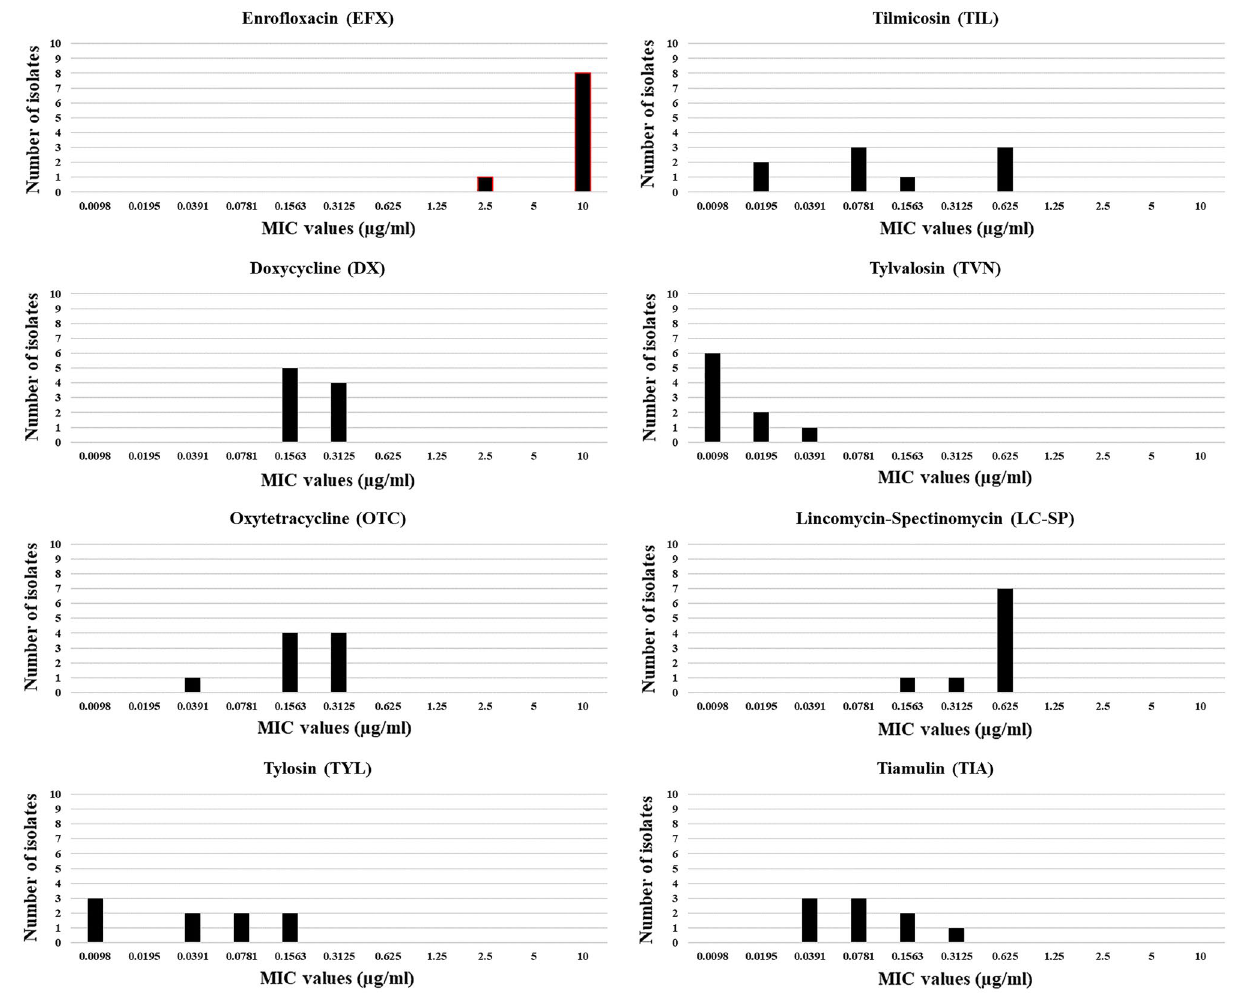
Figure 2. Bar charts illustrate the distribution of M. synoviae isolates among the final MIC values of tested antibiotics, including enrofloxacin, doxycycline, oxytetracycline, tylosin, tilmicosin, tylvalosin, lincomycin- spectinomycin, and